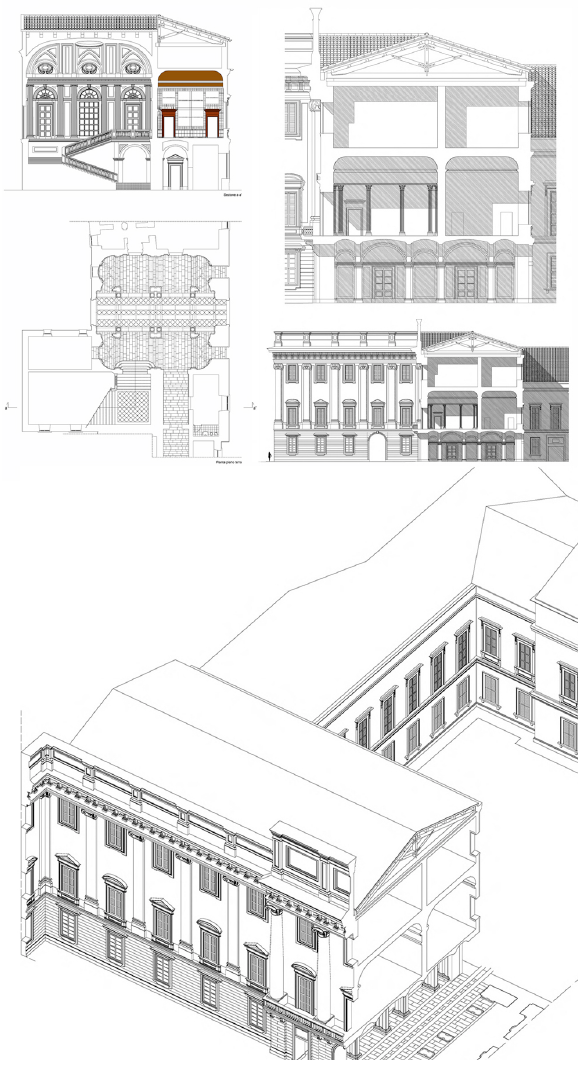
Figure 9 - Royal Palace in Milan, Italy. Dimensional and architectural survey. Course of Drawing, Milan Polytechnic (De Masi,